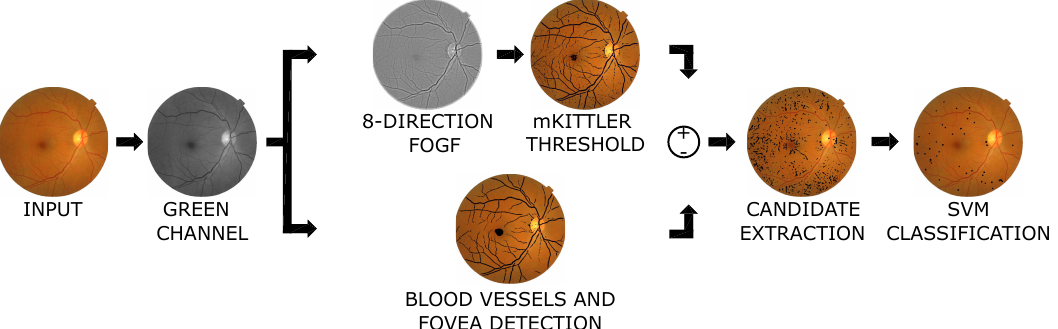
Figure 3. Flowchart of the proposed methodology to classify